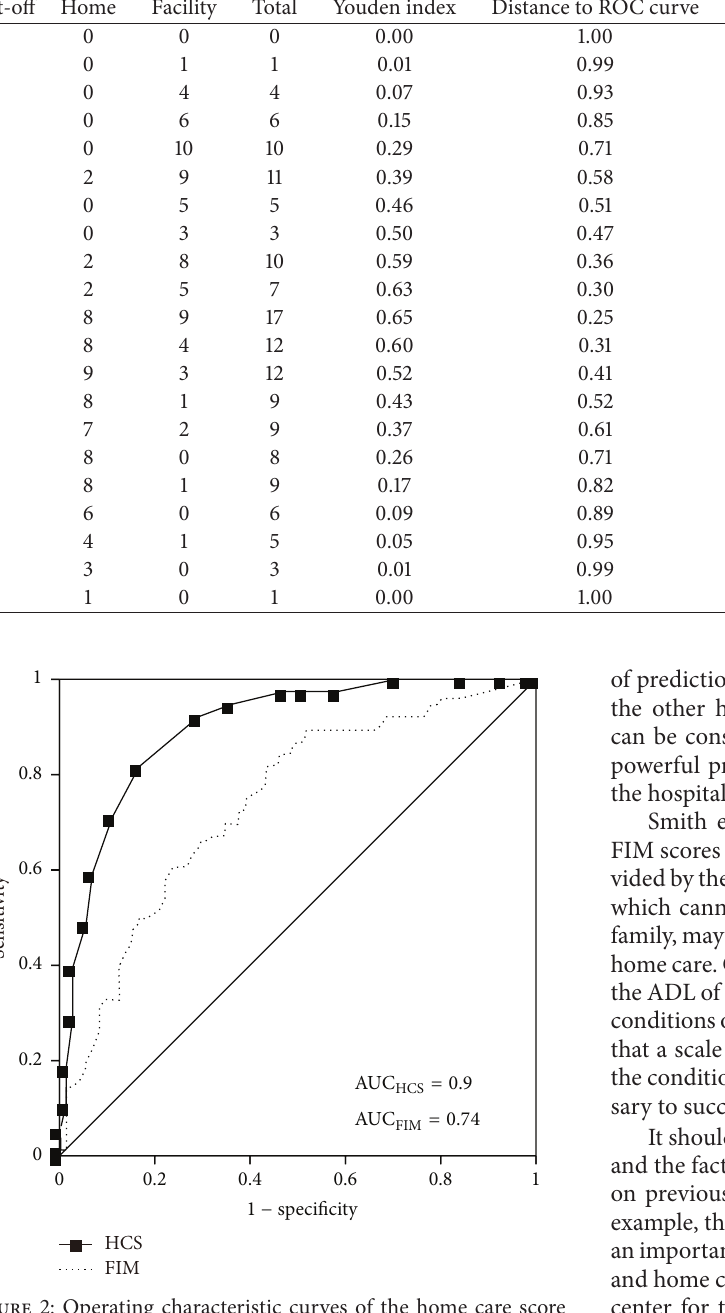
Figure 2: Operating characteristic curves of the home care score (HCS) and functional independence measure (FIM). AUC, area under the